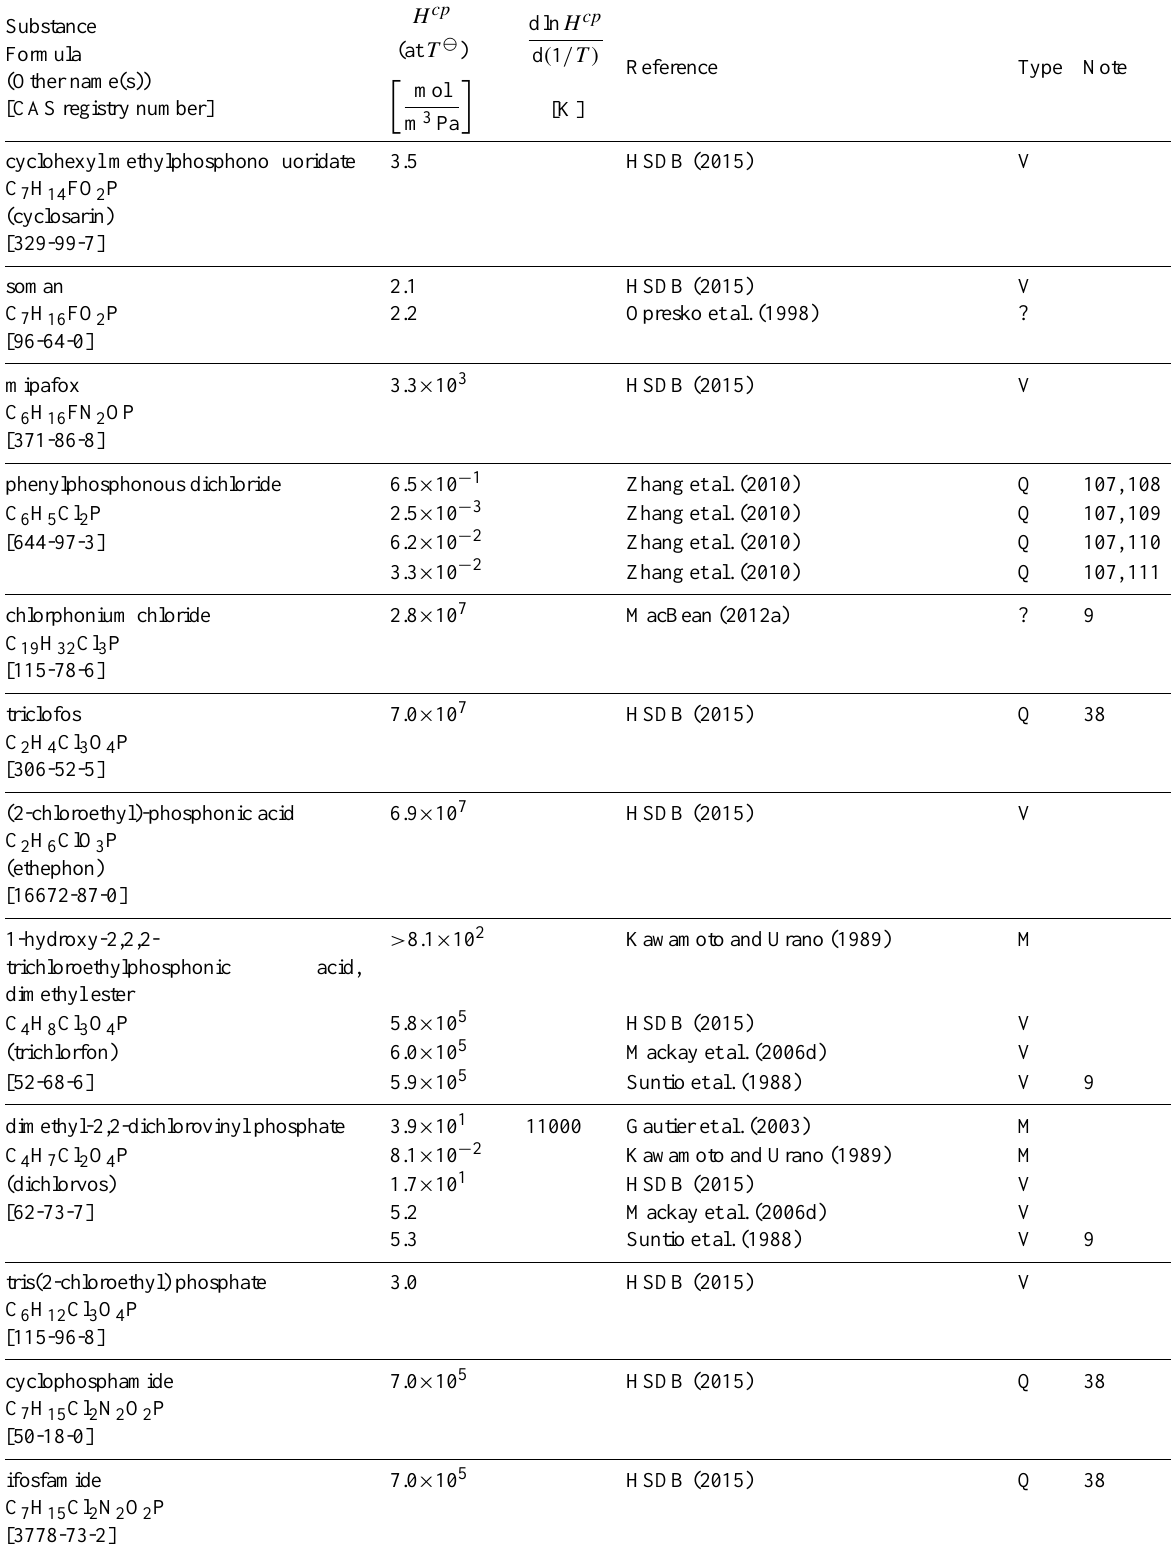
Table 6: Henry’s law constants for water as solvent